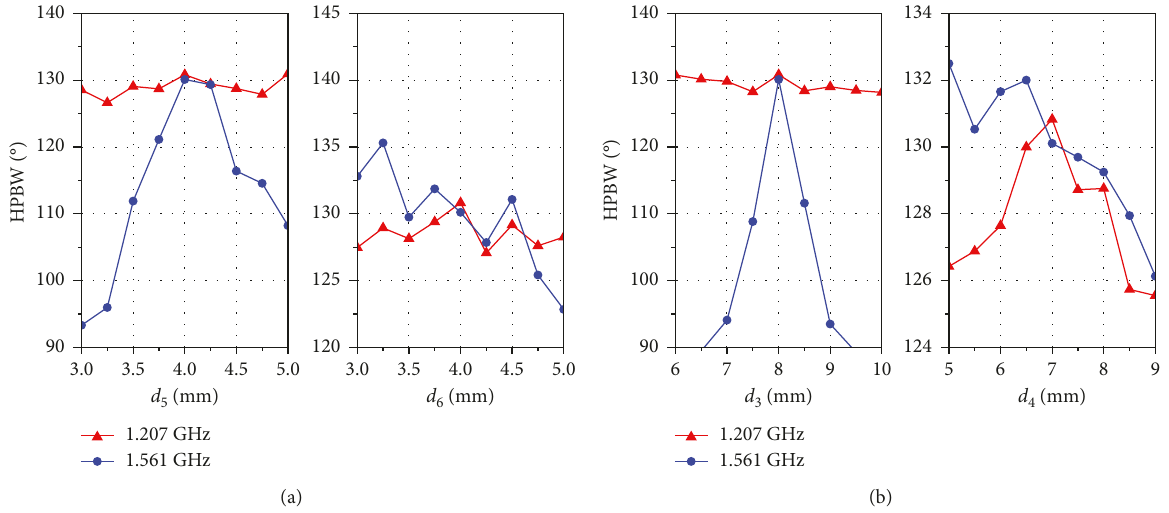
Figure 11: Effects of (a) the width and (b) the gap of the APMS on the